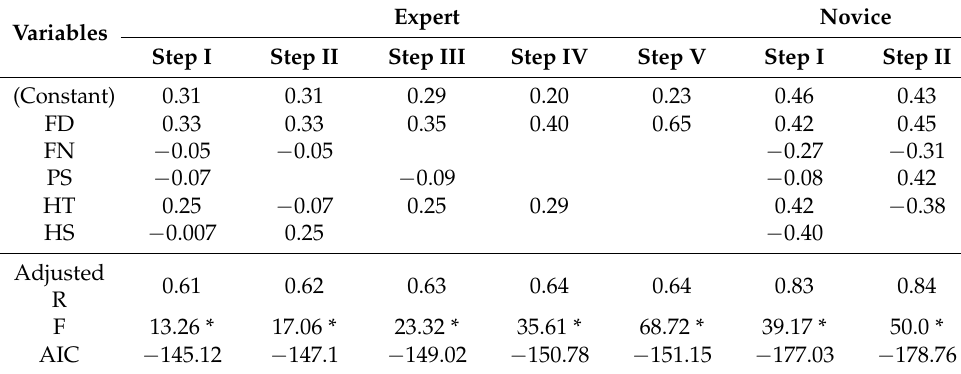
Table 7. Stepwise regression (backward) results with unified PVT measure as response and eye movement measures as predictors for both expert and novice